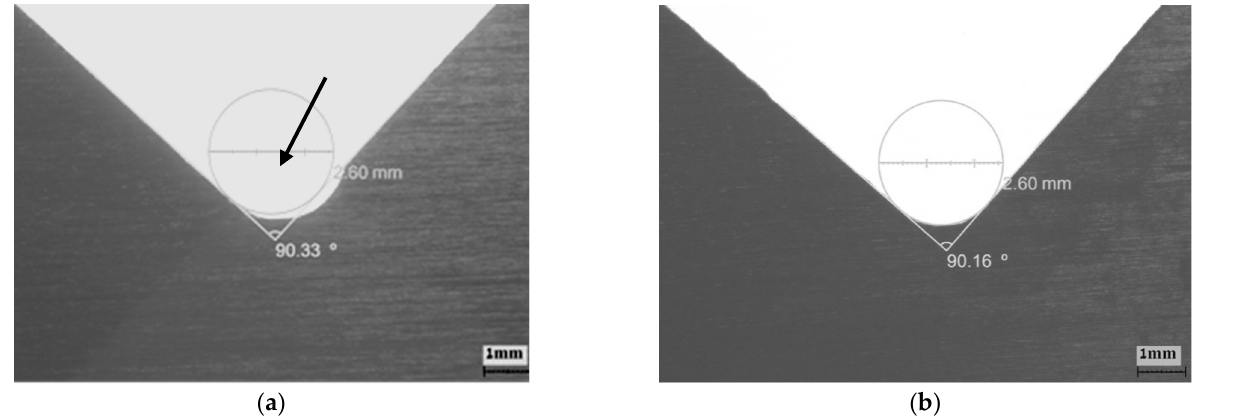
Figure 25. Radius profile and the angle notch for the shear coupon machined in ( a ) mechanical (arrow mark the defect) and ( b ) water cutting. Table 9. Shear values for different radius profile and thickness.